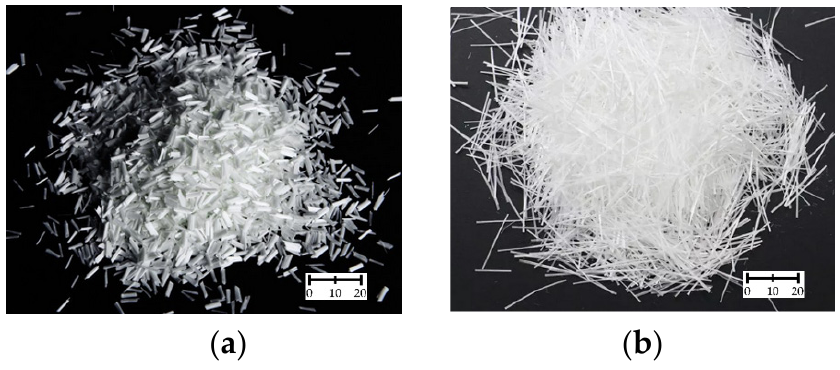
Figure 1. Glass fibers: ( a ) l f = 6 mm [10]; ( b ) l f = 24 mm [11]. Table 1. Types of glass fibers [12,13].